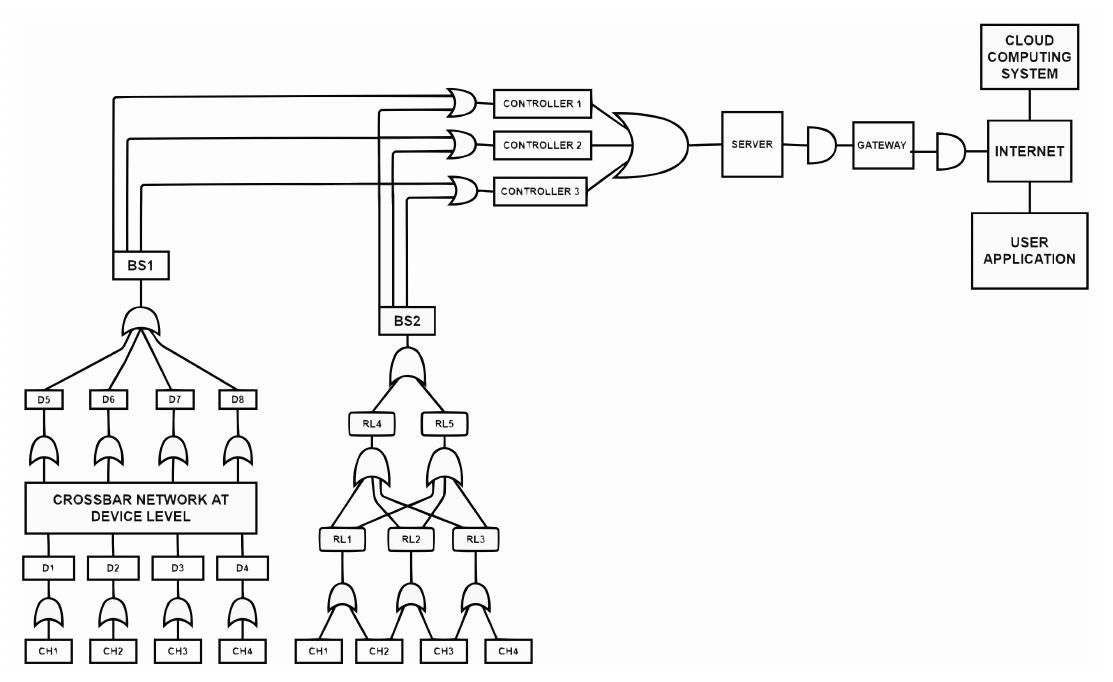
Figure 6. FTA model for revised IoT network.